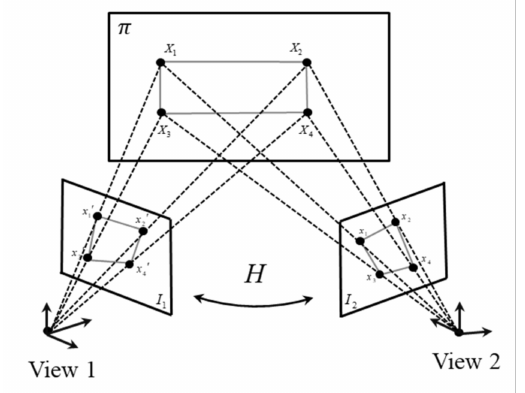
Figure 2. Transformation between two